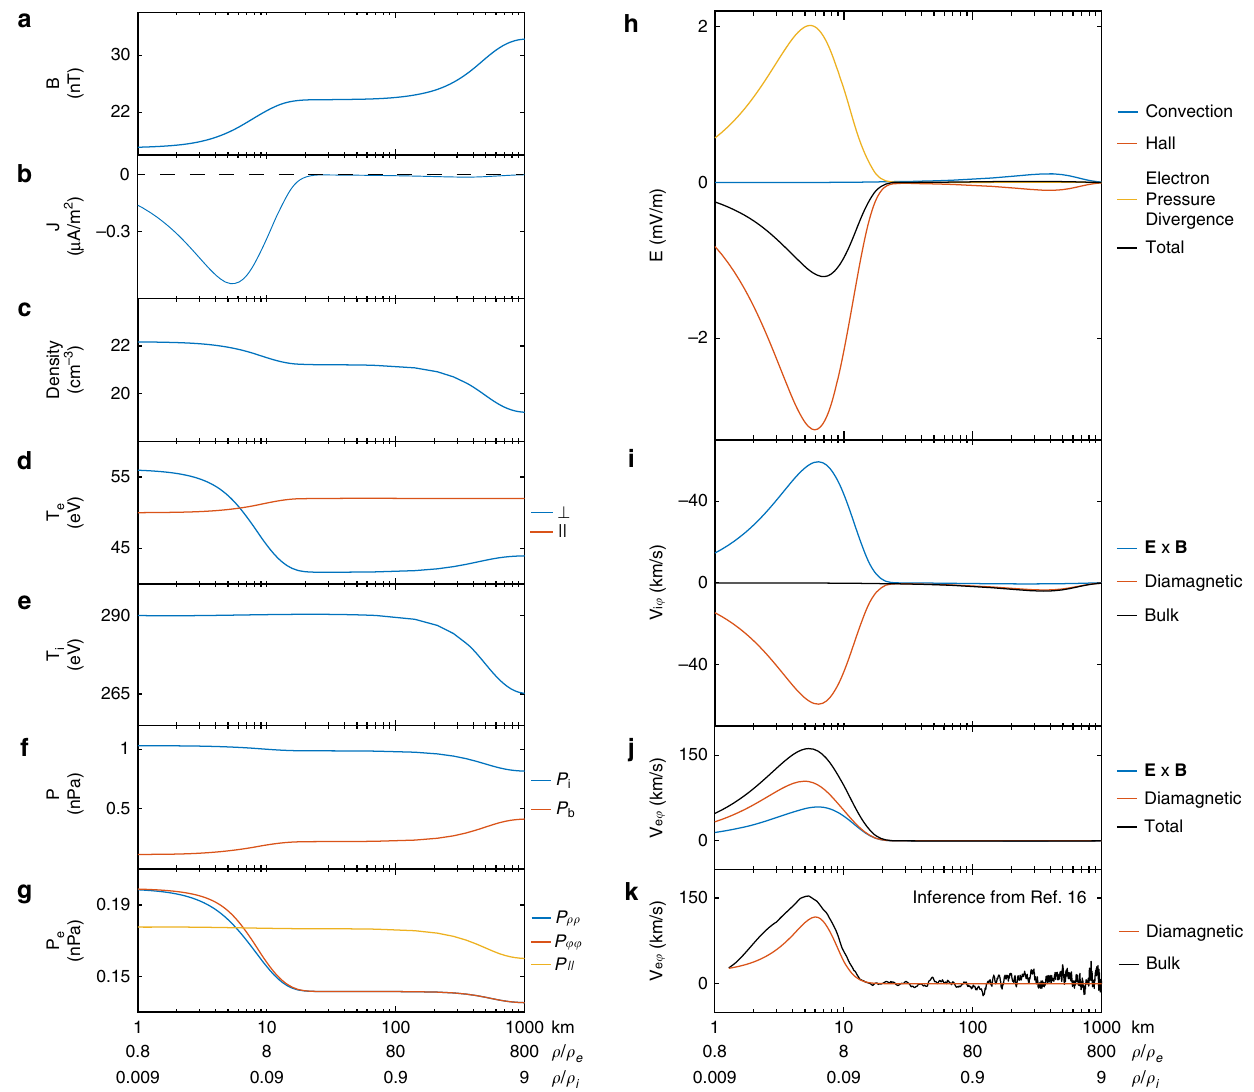
Fig. 5 The modeled electromagnetic fi eld and particle pro fi les of the nested cavities. The horizontal axis represents the distance from the cavity center in the logarithmic scale, also normalized by thermal electron and proton gyroradii. Panels a – g show the radial pro fi les of the magnetic fi eld, electric current, plasma density, electron parallel and perpendicular temperatures, proton temperature, proton and magnetic pressure, and the diagonal terms of the electron pressure tensor. Panel h shows the distributions of the radial electric fi eld, which according to the generalized Ohm ’ s law can be divided into the convection, Hall, and electron pressure divergence terms. Panels i and j show the proton and electron bulk velocities in the azimuthal direction (together with their E × B and diamagnetic components), respectively. Panel k shows the electron bulk velocity inferred from ref. 16 in direct comparison with panel j